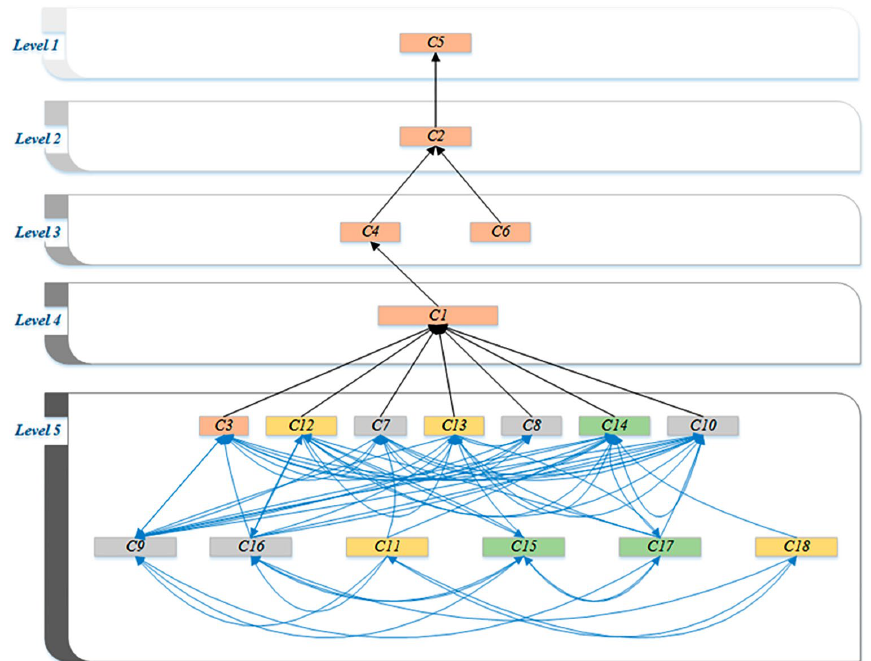
Figure 2. Final performance evaluation model for new service development in healthcare industry using